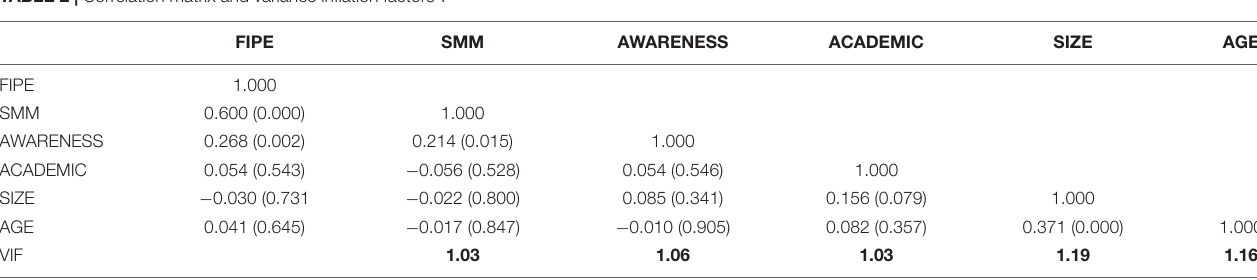
TABLE 2 | Correlation matrix and variance inflation